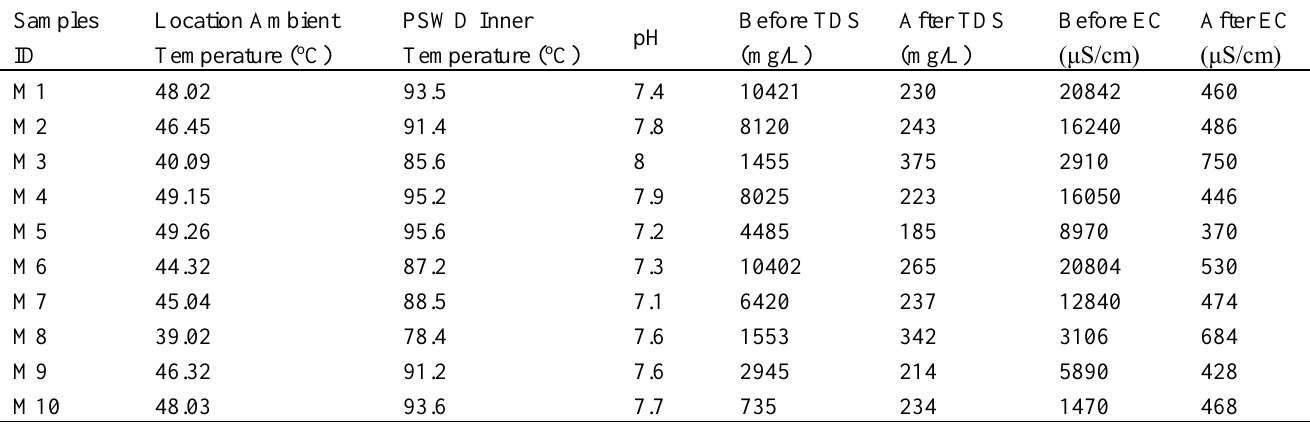
Results of Mithi water samples before and after treatment Samples